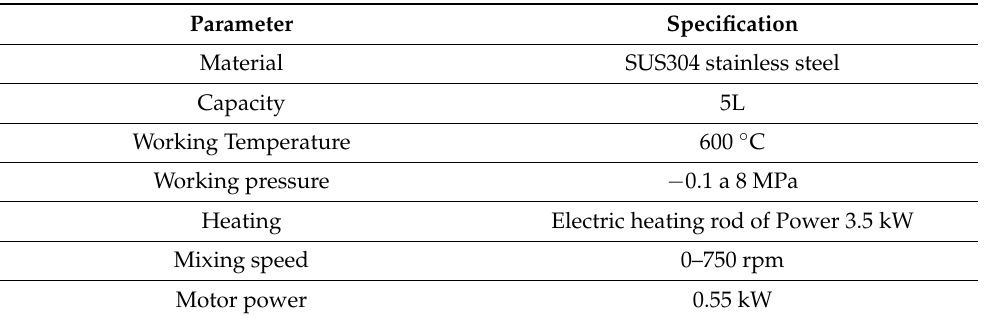
Table 2. Pyrolysis process conditions.